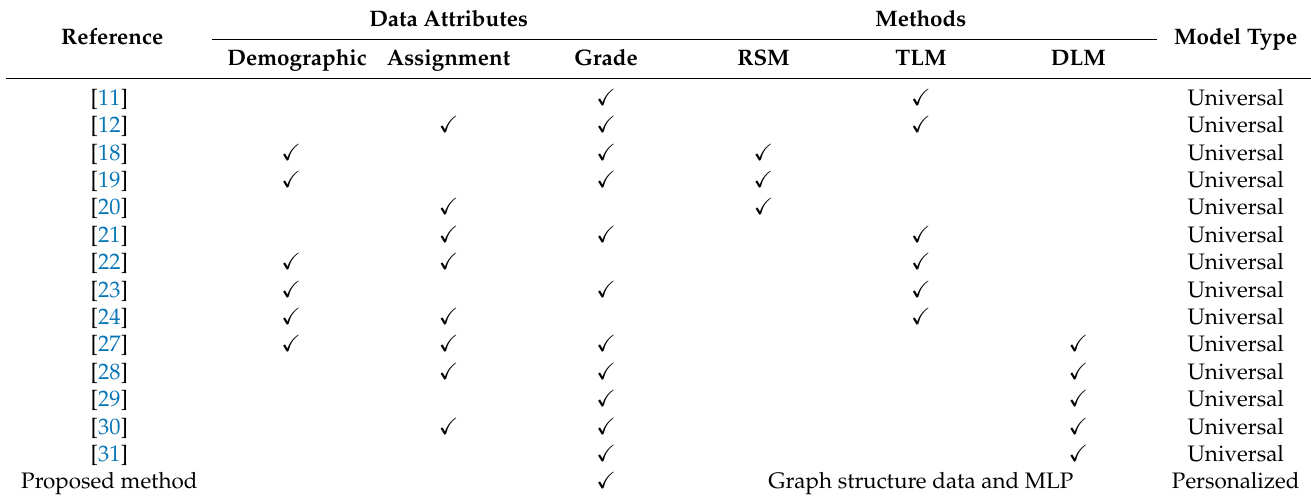
Table 1. Recent Studies on Student Performance